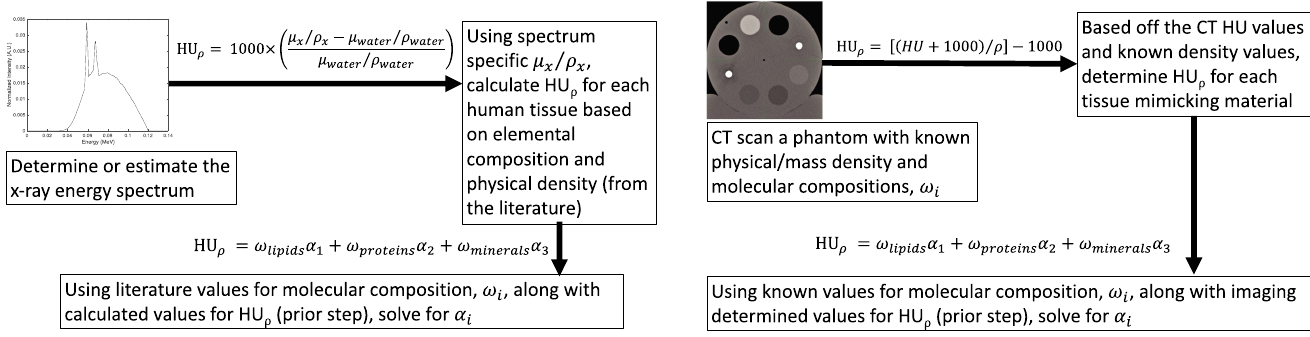
PLOS ONE | https://doi.org/10.1371/journal.pone.0244861 December31,